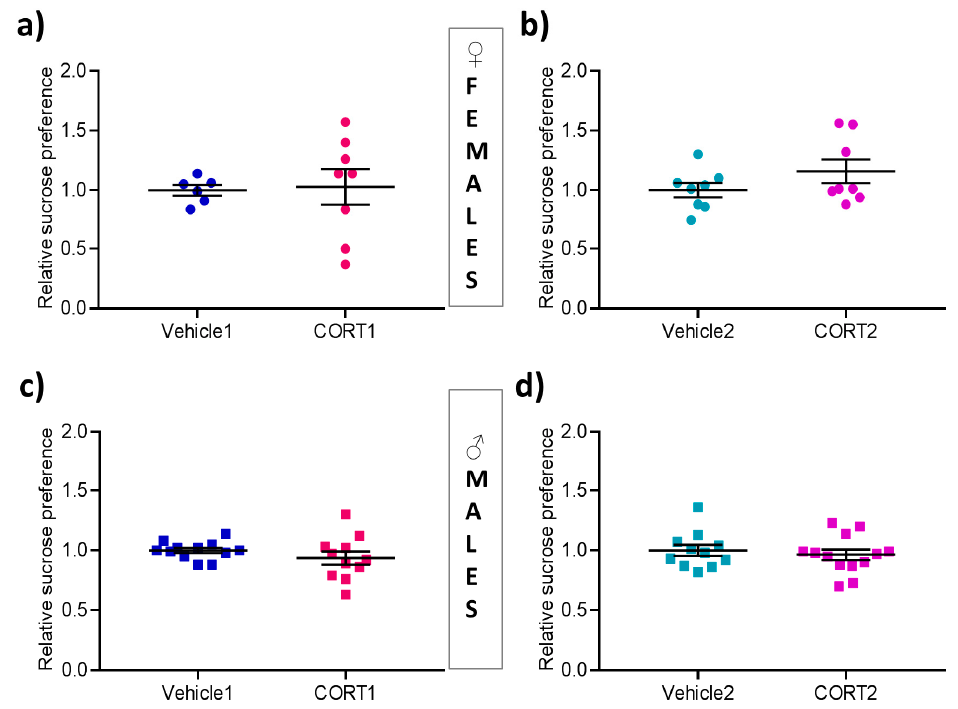
Figure 2. Results of Sucrose Preference Test in CORT mice. Evaluation of the sucrose preference test showing relative % of sucrose preference in ( a – b ) female ( c – d ) male mice. All values are presented as mean ± SEM ( n = 6–13 per group). Statistical significances indicate results of Student‘s t-test. * p < 0.05.